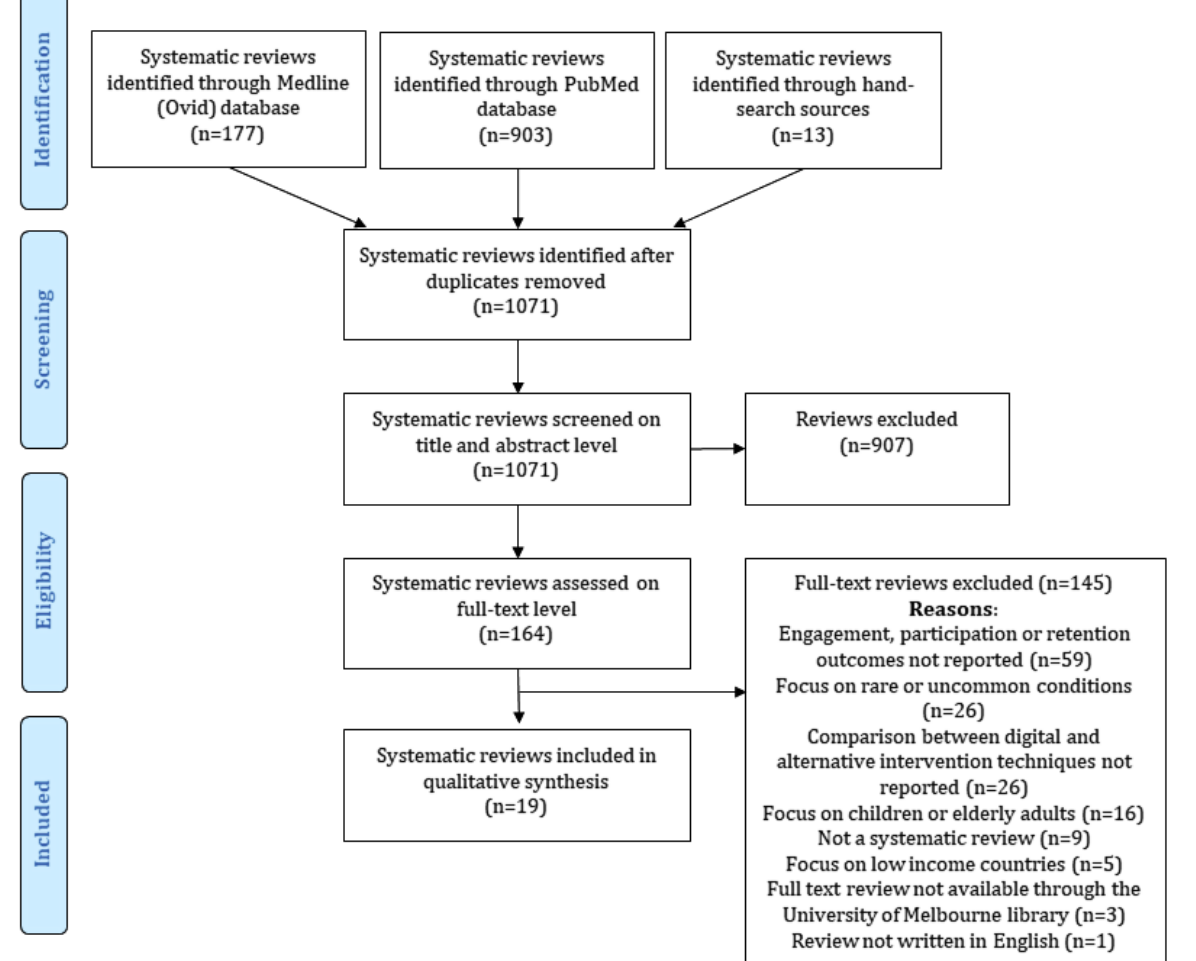
Figure 1. Search and screening